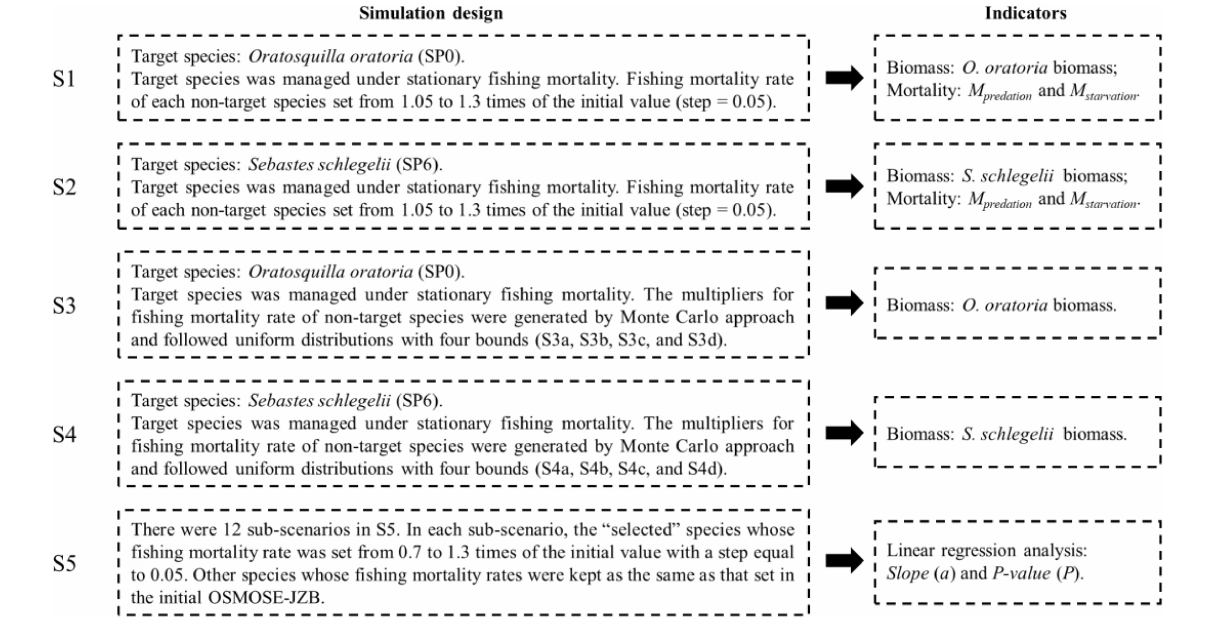
( Figure 4C ). By contrast, age-0 S. schlegelii predation mortality had a decrease trend with the increased fishing pressure to other species ( Figure 4B ). The age-1 S. schlegelii predation mortality seemed not to change under different fishing pressure levels ( Figure 4D ). It suggested S. schlegelii had a strong resistibility to changes in trophic interactions. There were smaller changes in the starvation mortality compared to the predation mortality ( Figure 5 ). Both two age groups of O. oratoria experienced a lower starvation mortality after the fishing pressure to other had a bigger change than age-0 O. oratoria ( Figures 5A,C